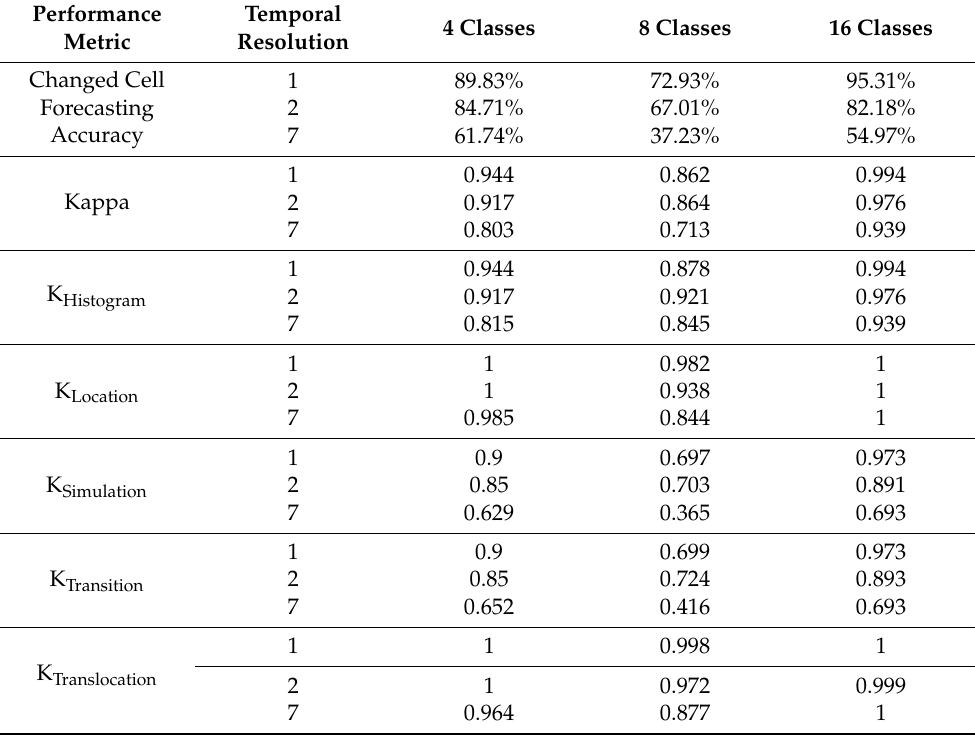
Table 9. Performance metrics obtained using Subset B of the hypothetical dataset (including timesteps 15 to 29), featuring 15-year LC datasets with 4, 8, and 16